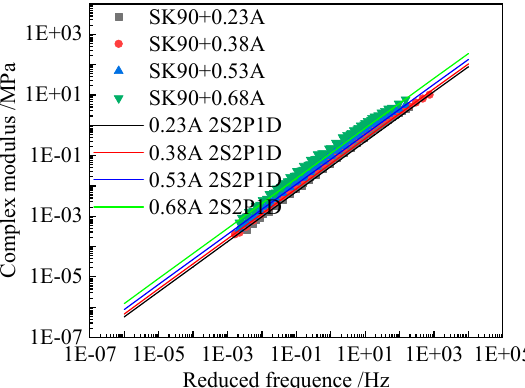
Figure 7. Comparison between the tested complex modulus master curves and 2S2P1D model fitted results of SK90 (A) asphalt mastics.